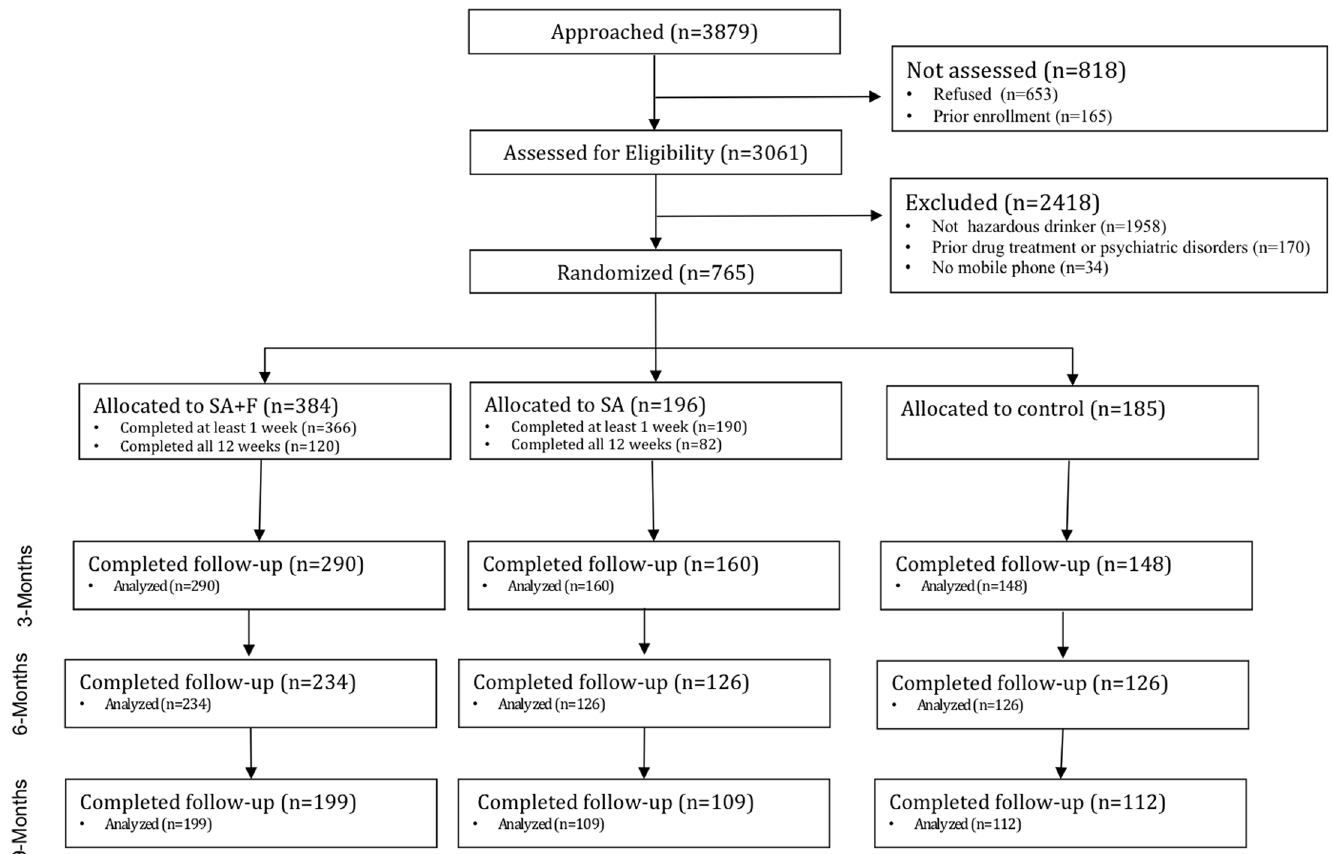
Fig 1. CONSORT Diagram. SA + F, SMS Assessments + Feedback intervention; SA, SMS